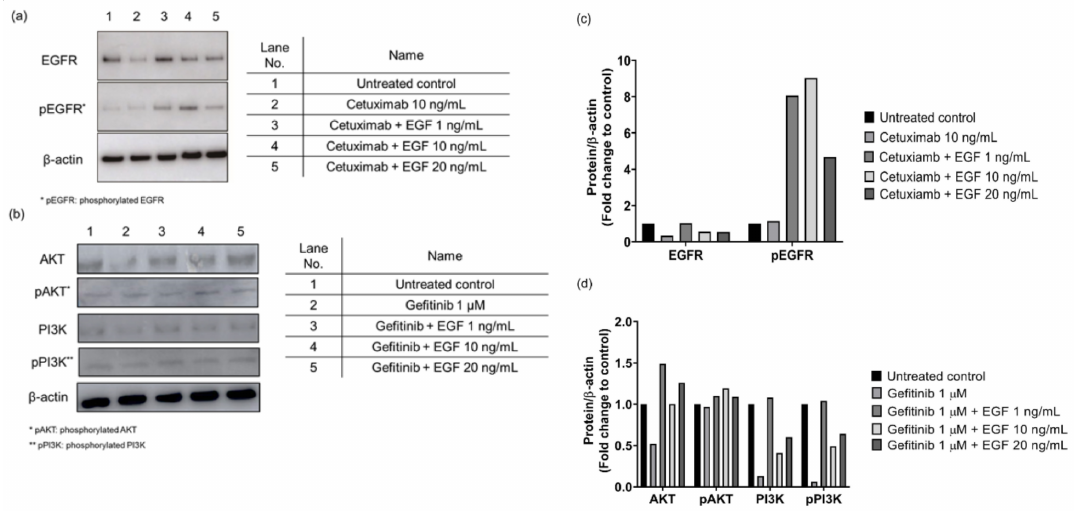
Figure 1. The recombinant human epidermal growth factor (rhEGF) increased the epidermal growth factorreceptorinhibitor(EGFR)andEGFRsignalingwasinterruptedbyEGFRinhibitors. Theexpression of the EGFR of human epidermal keratinocytes was decreased by cetuximab treatment. However, EGFR andphosphorylatedEGFRexpressionwasinducedbyrhEGFtreatment( a ). Similarly, ingefitinib-treated keratinocytes, it was observed that phosphorylated AKT and PI3K were slightly decreased. On the other hand, rhEGF and gefitnib co-treatment induced AKT and PI3K phosphorylation ( b ). Representative Western blot images and relative densitometric bar graphs of EGFR and phosphorelated EGFR ( c ) β -actin was used as protein loading control. rhEGF treatment induced pEGFR expression decreased by cetuximab ( c ). Representative Western blot images and relative densitometric bar graphs of AKT, PI3K, phosphorylated AKT, and phosphorylated PI3K ( d ) β -actin was used as protein loading control.